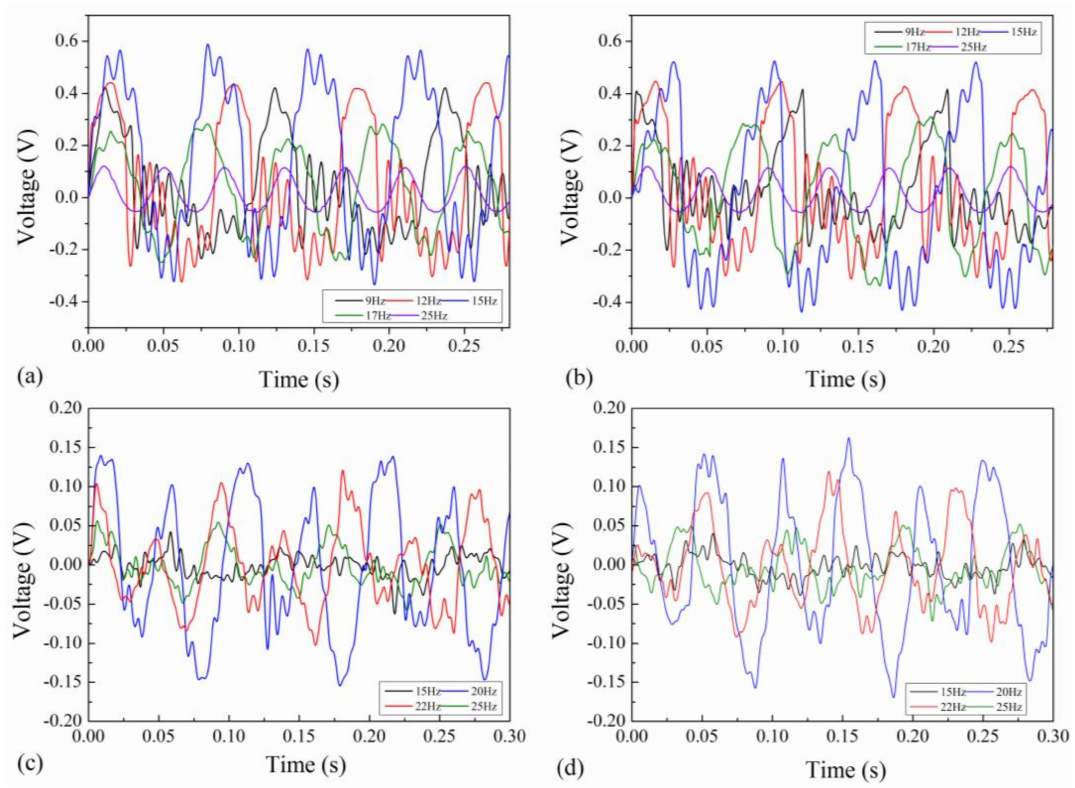
Figure 6. The time-dependent open-circuit output voltage of the EVEH on ( a ) Z-direction in top coil; ( b ) Z-direction in bottom coil; ( c ) X-direction in top coil; and ( d ) X-direction in bottom coil. The peak-to-peak open-circuit output voltage of the EVEH as a function of frequency is shown in Figure 7. The output voltages of the EVEH on Z and X directions are measured by both sweeping up and sweeping down the frequency. The output voltage in both top and bottom coils are measured.